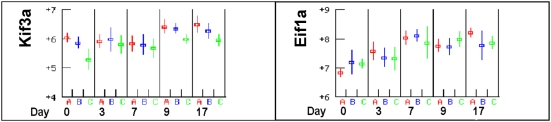
EPO responsive genes.
Kif3a and Eif1a are EPO responsive genes but respond to inflammatory signals as well. Consequently their positive response to infection may not be related to induction of erythropoiesis.